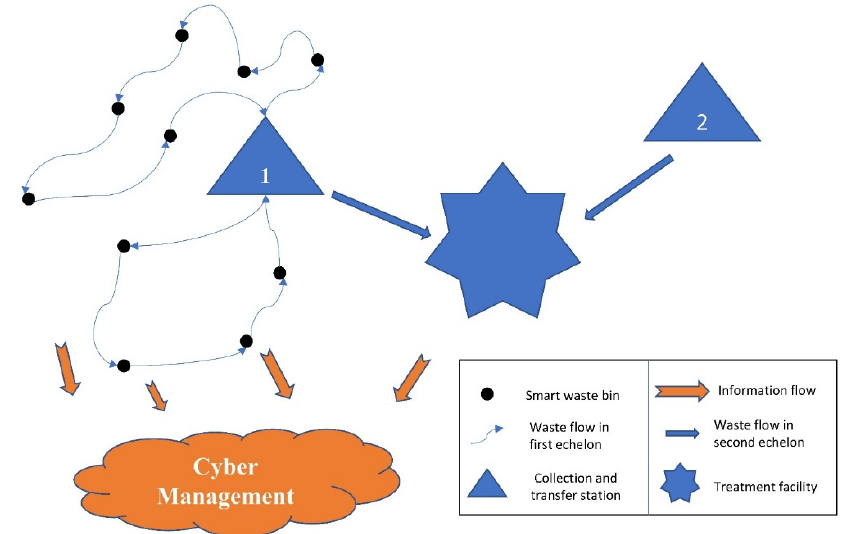
Figure 2. Information and waste flow.